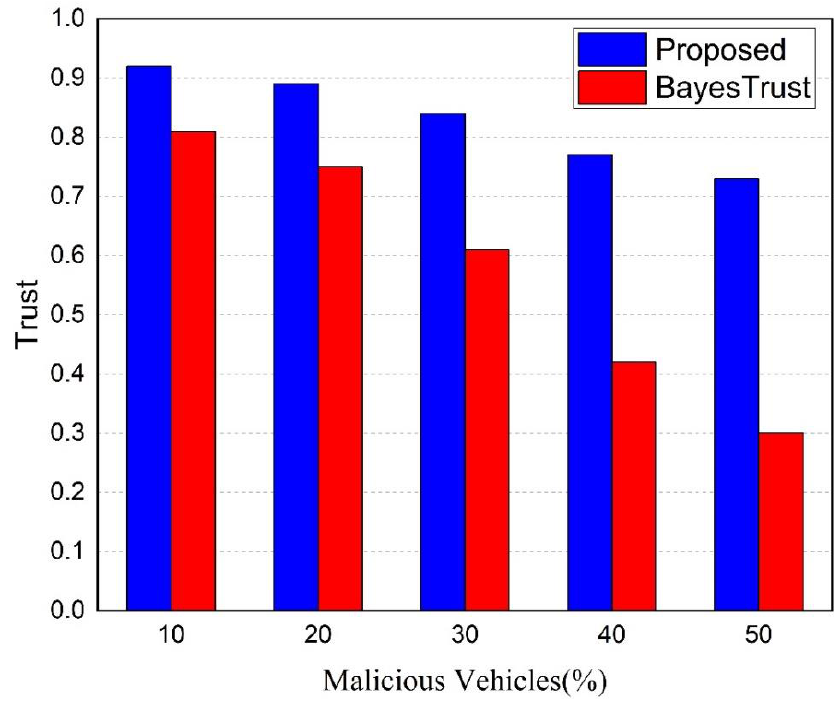
Figure 11. Trust